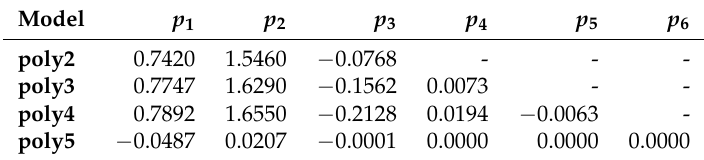
Table 2. Polynomial curve fitting coefficients with all participants’ data (inclusive) for Equation (9).